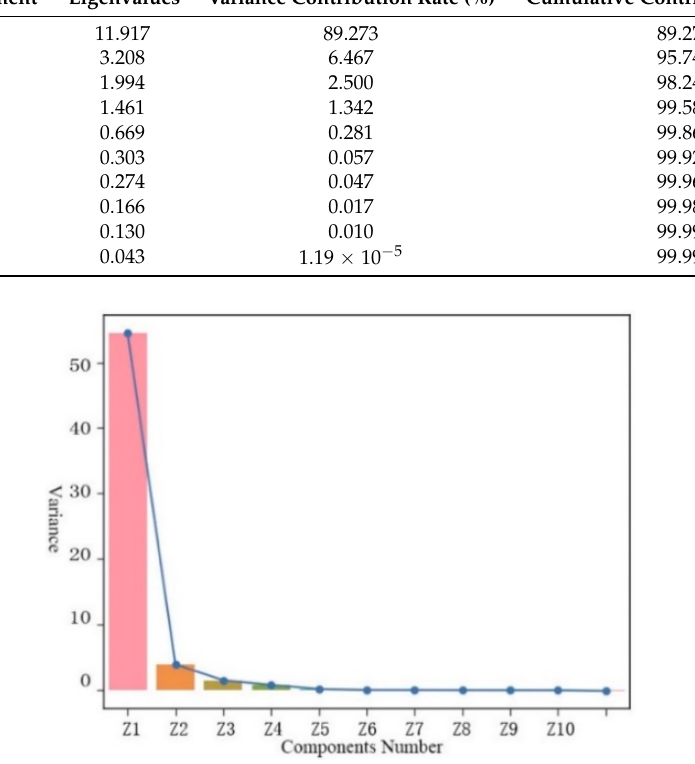
Figure 7. The scatter of variance relative to the number of component. Table 1. Eigenvalues and contribution.